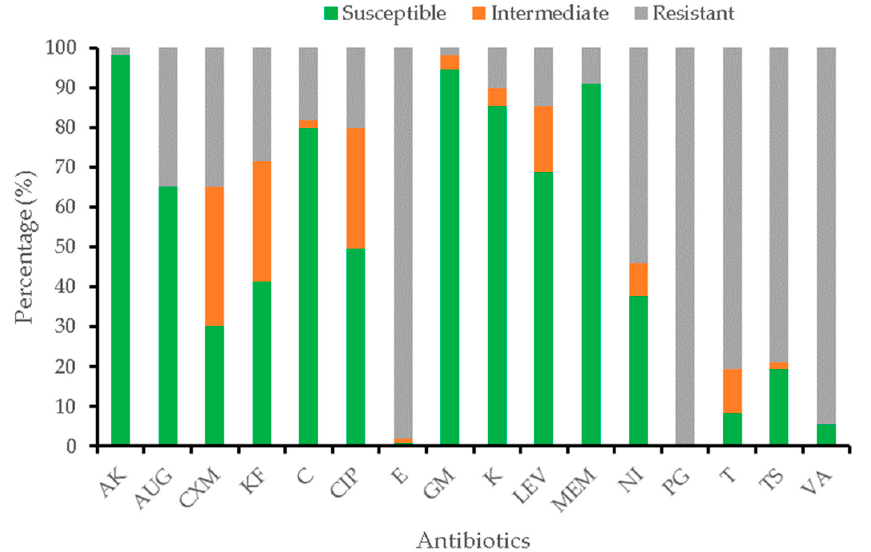
Figure 3. Antibiogram profile of L. monocytogenes isolates against selected antibiotics. AK = Amikacin; AUG = Amoxicillin-clavulanic acid; CXM = Cefuroxime; KF = Cephalotin; C = Chloramphenicol; CIP = Ciprofloxacin; E = Erythromycin; GM = Gentamicin; K = Kanamycin; LEV = Levofloxacin; MEM = Meropenem; NI = Nitrofurantoin; PG = Penicillin G; T = Tetracycline; TS = Trimethoprim- Sulfamethoxazole; VA = Vancomycin.